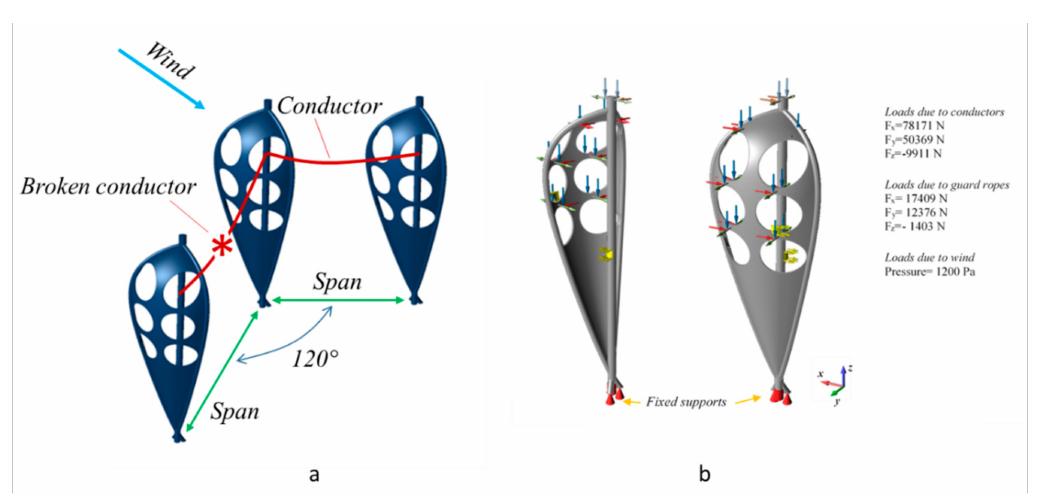
Figure 11. ( a ) The most unfavorable Load Condition (LC#2), with two adjacent spans (in green) that form an angle of 120 ◦ , and a broken conductor; ( b ) boundary, constraints, and load conditions (common to all the three